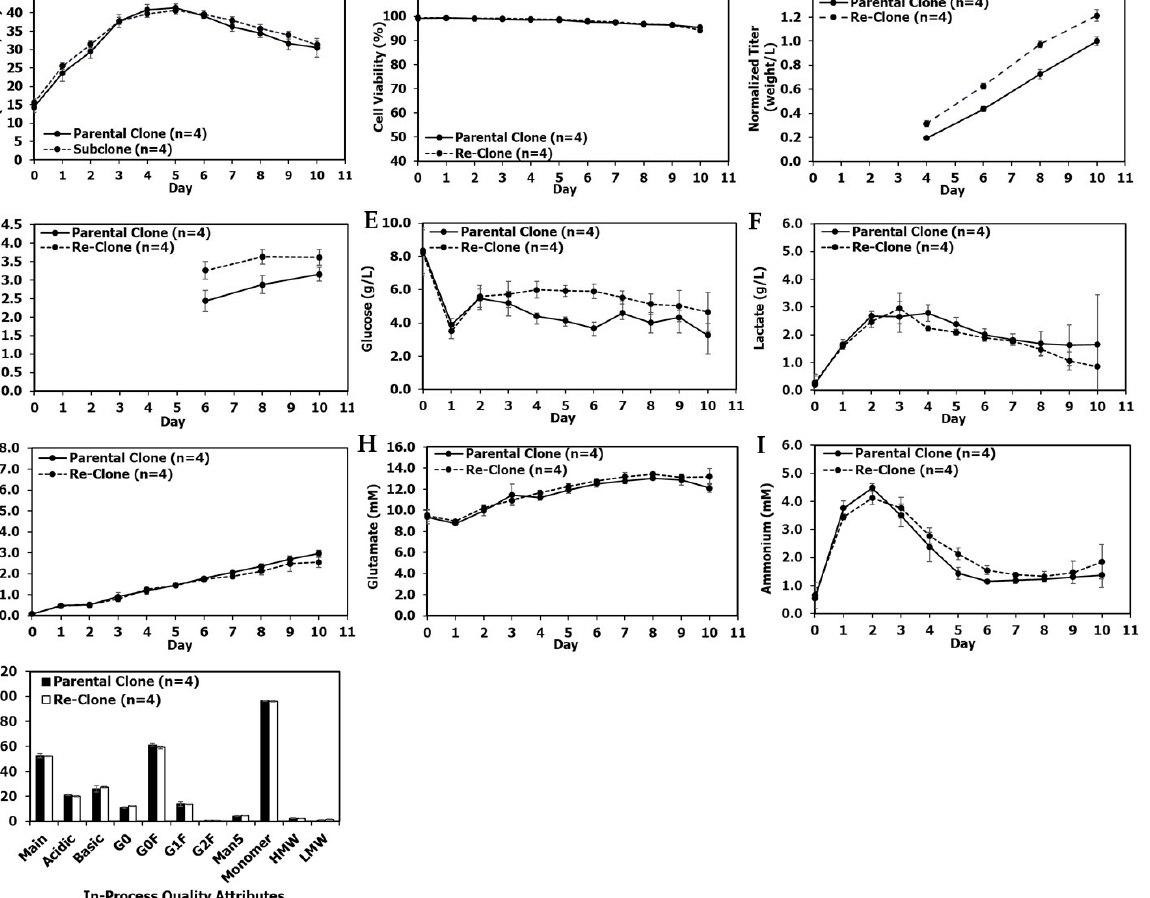
Figure 10. mAb3 production 5L bioreactor culture performance, metabolite and quality attribute profiles between the parental and re-clone. ( A ) Production 5-L bioreactor VCD, ( B ) production viability, ( C ) normalized titer, ( D ) normalized Qp, ( E ) production glucose profiles, ( F ) production lactate profiles, ( G ) production glutamine profiles, ( H ) production glutamate profiles, ( I ) production ammonium profiles, ( J ) in-process quality attribute profiles on day 10 at harvest. The parental clone day 10 titer was normalized as 1. The values are reported as average ± standard deviation (n = 4).